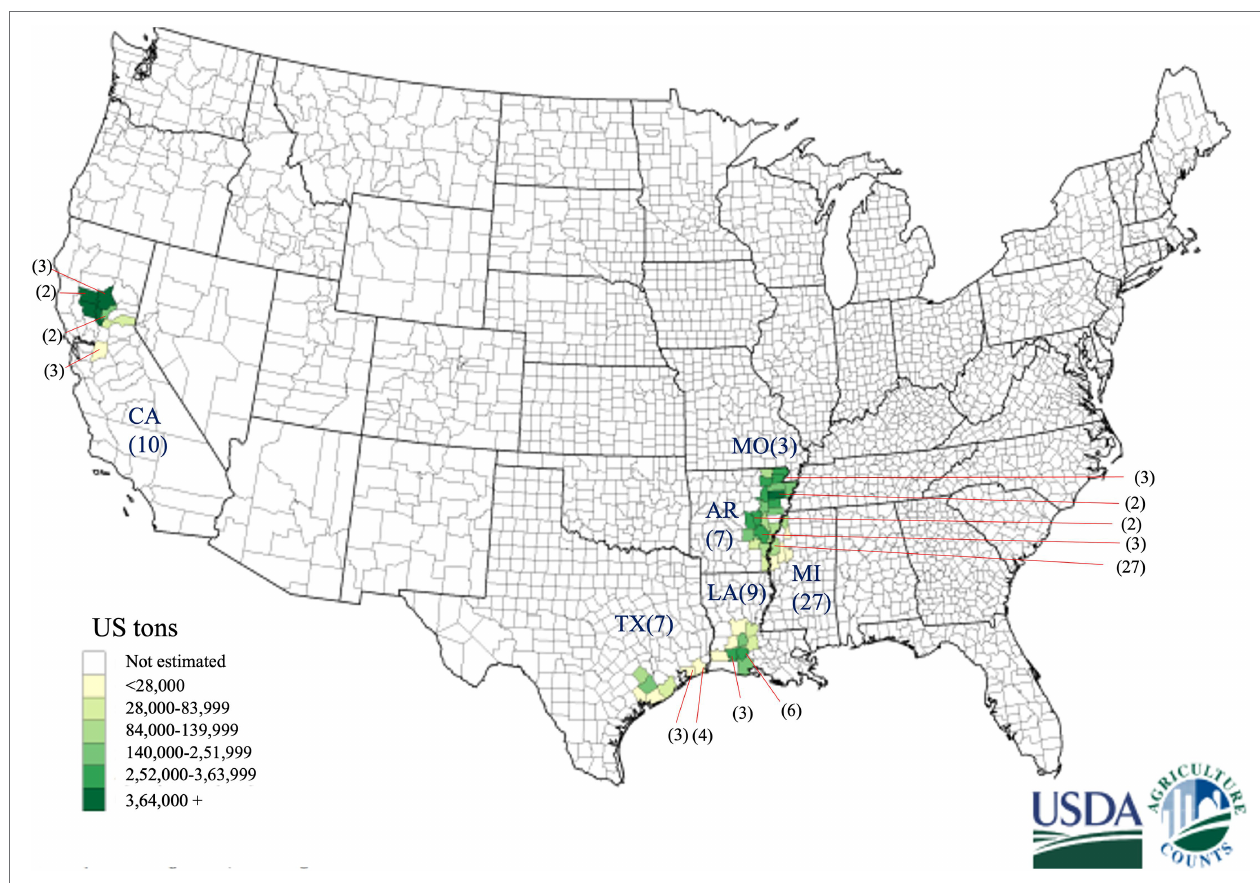
FIGURE 1 | Geographical distribution of 63 Tilletia horrida isolates in Arkansas (AR), California (CA), Louisiana (LA), Mississippi (MI), Missouri (MO), and Texas (TX), covering almost all rice-growing areas in the US. Gradient shading areas inside each state represent the rice production in the US in 2019 provided by the USDA National Agricultural statistics services. The number in the parentheses represents the number of isolates from each county pointed by the red